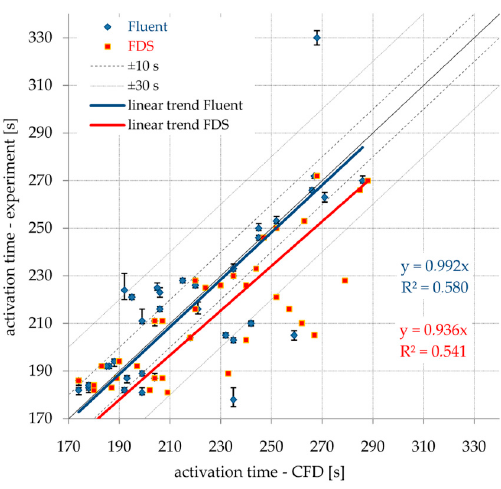
Figure 9. Activation time calculated in CFD analyses versus measured in experiment for all cases.